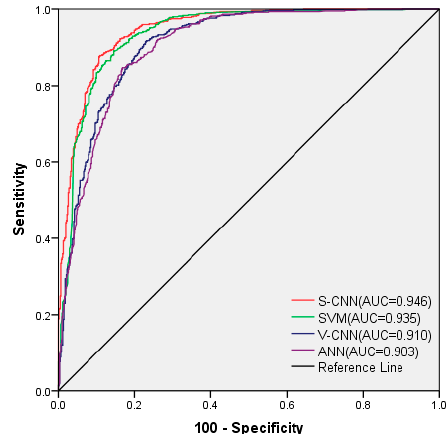
Figure 15. The ROC curves and AUC values of the four models on the training set.